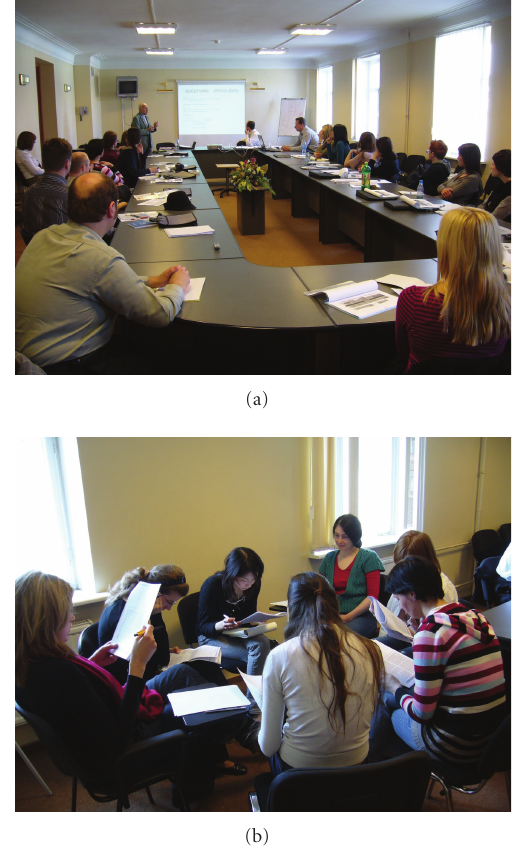
Figure 1: Scientific presentations and creative group discussions during the 1st International Neuroscience Summer School.